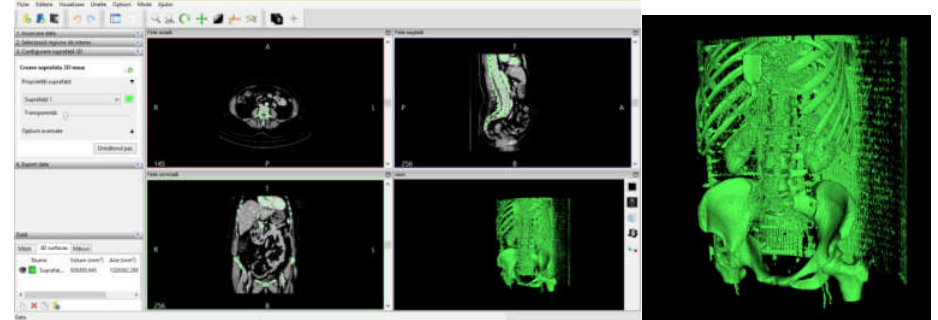
Figure 21. Primary geometry obtained in the InVesalius software.